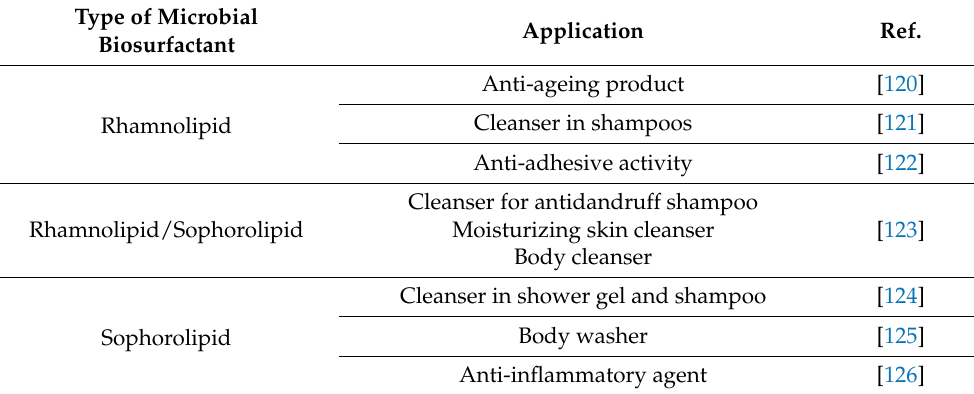
Table 2. Uses of microbial biosurfactants among cosmetic, personal care and pharmaceutical industries. Type of